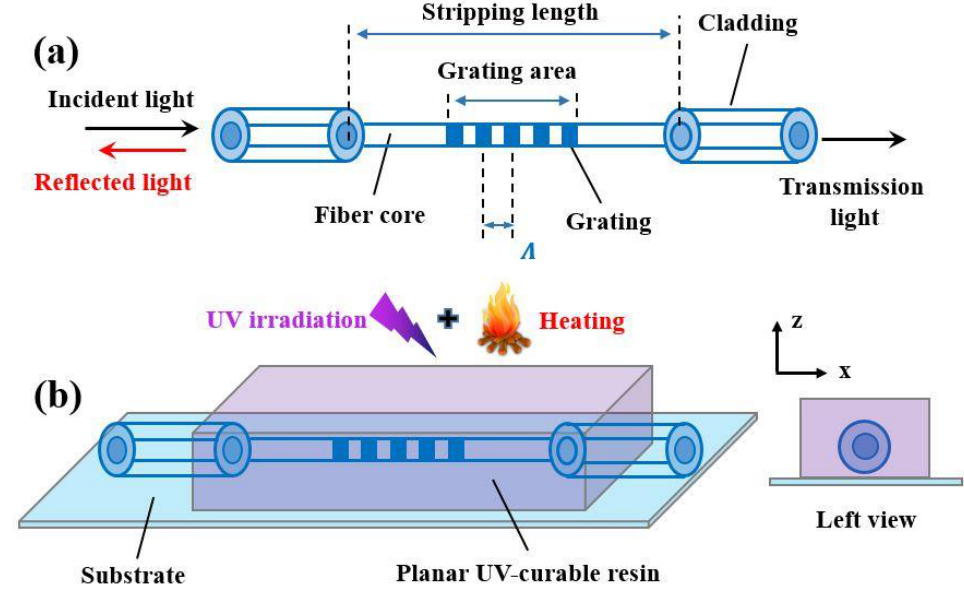
Figure 1. ( a ) Structure and principle of the uncoated FBG and ( b ) structure and left view of the FBG coated with a planar UV-curable resin. The substrate material is 304 stainless steel.